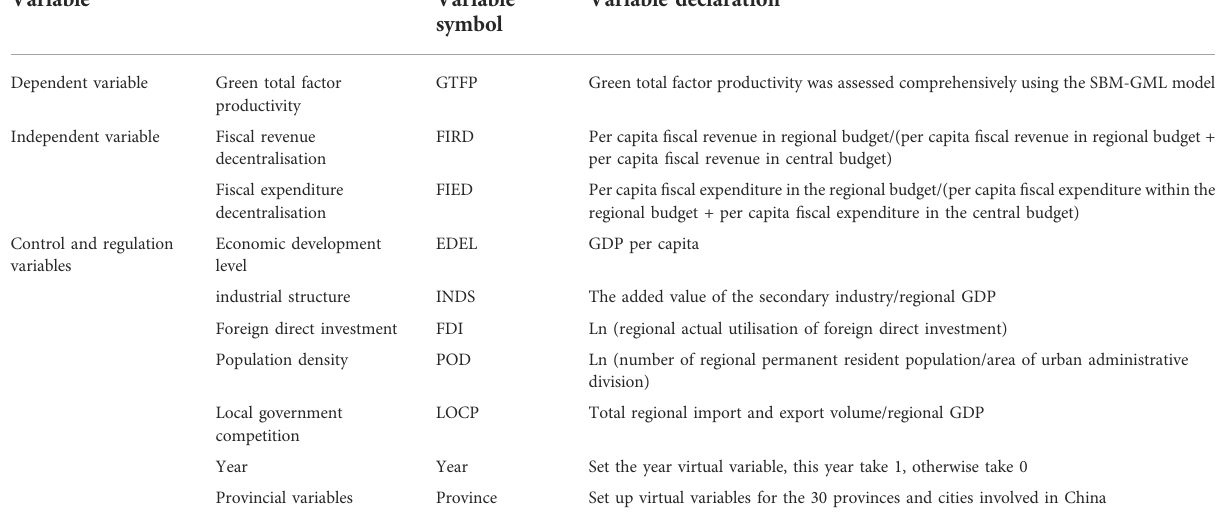
TABLE 2 Variable de fi nitions